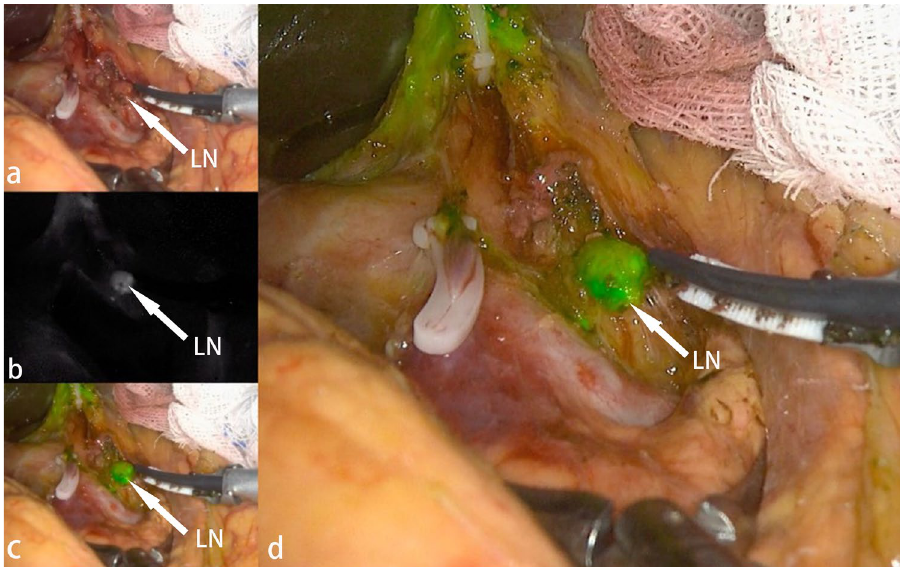
Figure 2. Lymph node images under different modes of laparoscopy with fluorescent labeling of indocyanine green. ( a ) Lymph nodes in normal mode. ( b ) Lymph nodes in contrast mode can more easily identify deeply stained lymph nodes. ( c , d )Green-stained lymph nodes under ICG-labeled fluorescence mode.